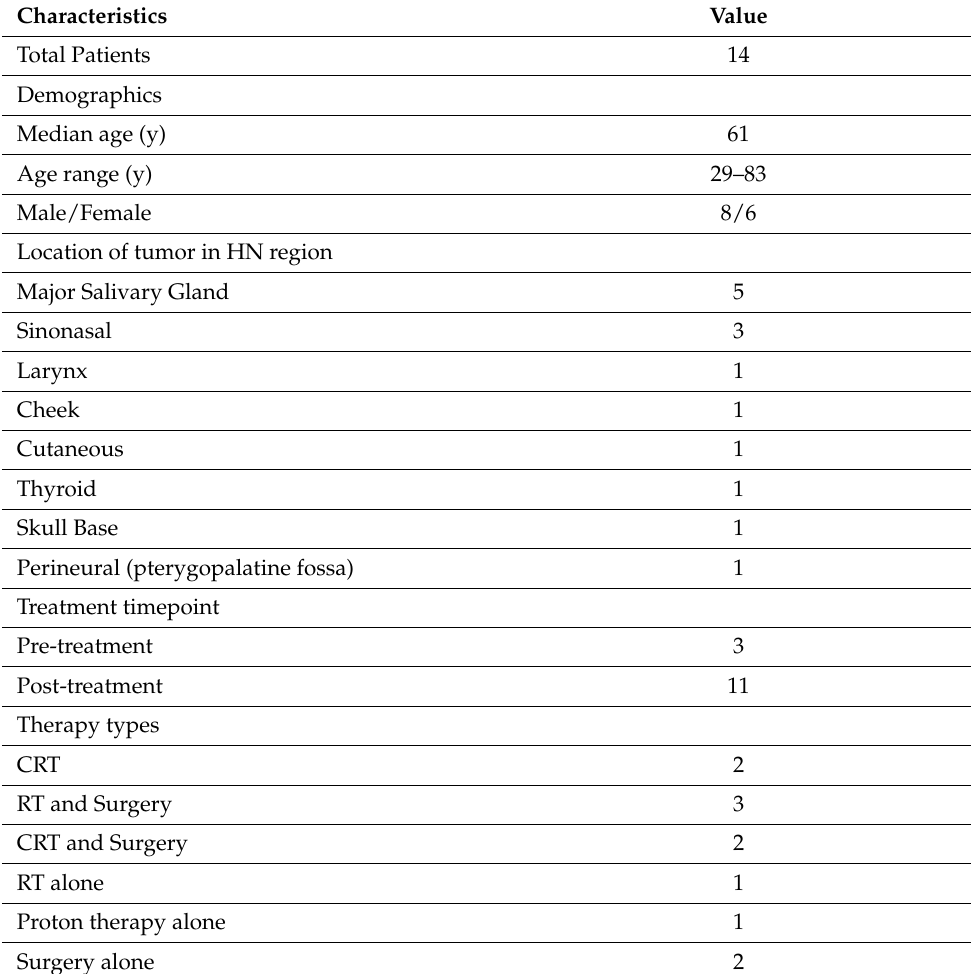
Table 1. Patient